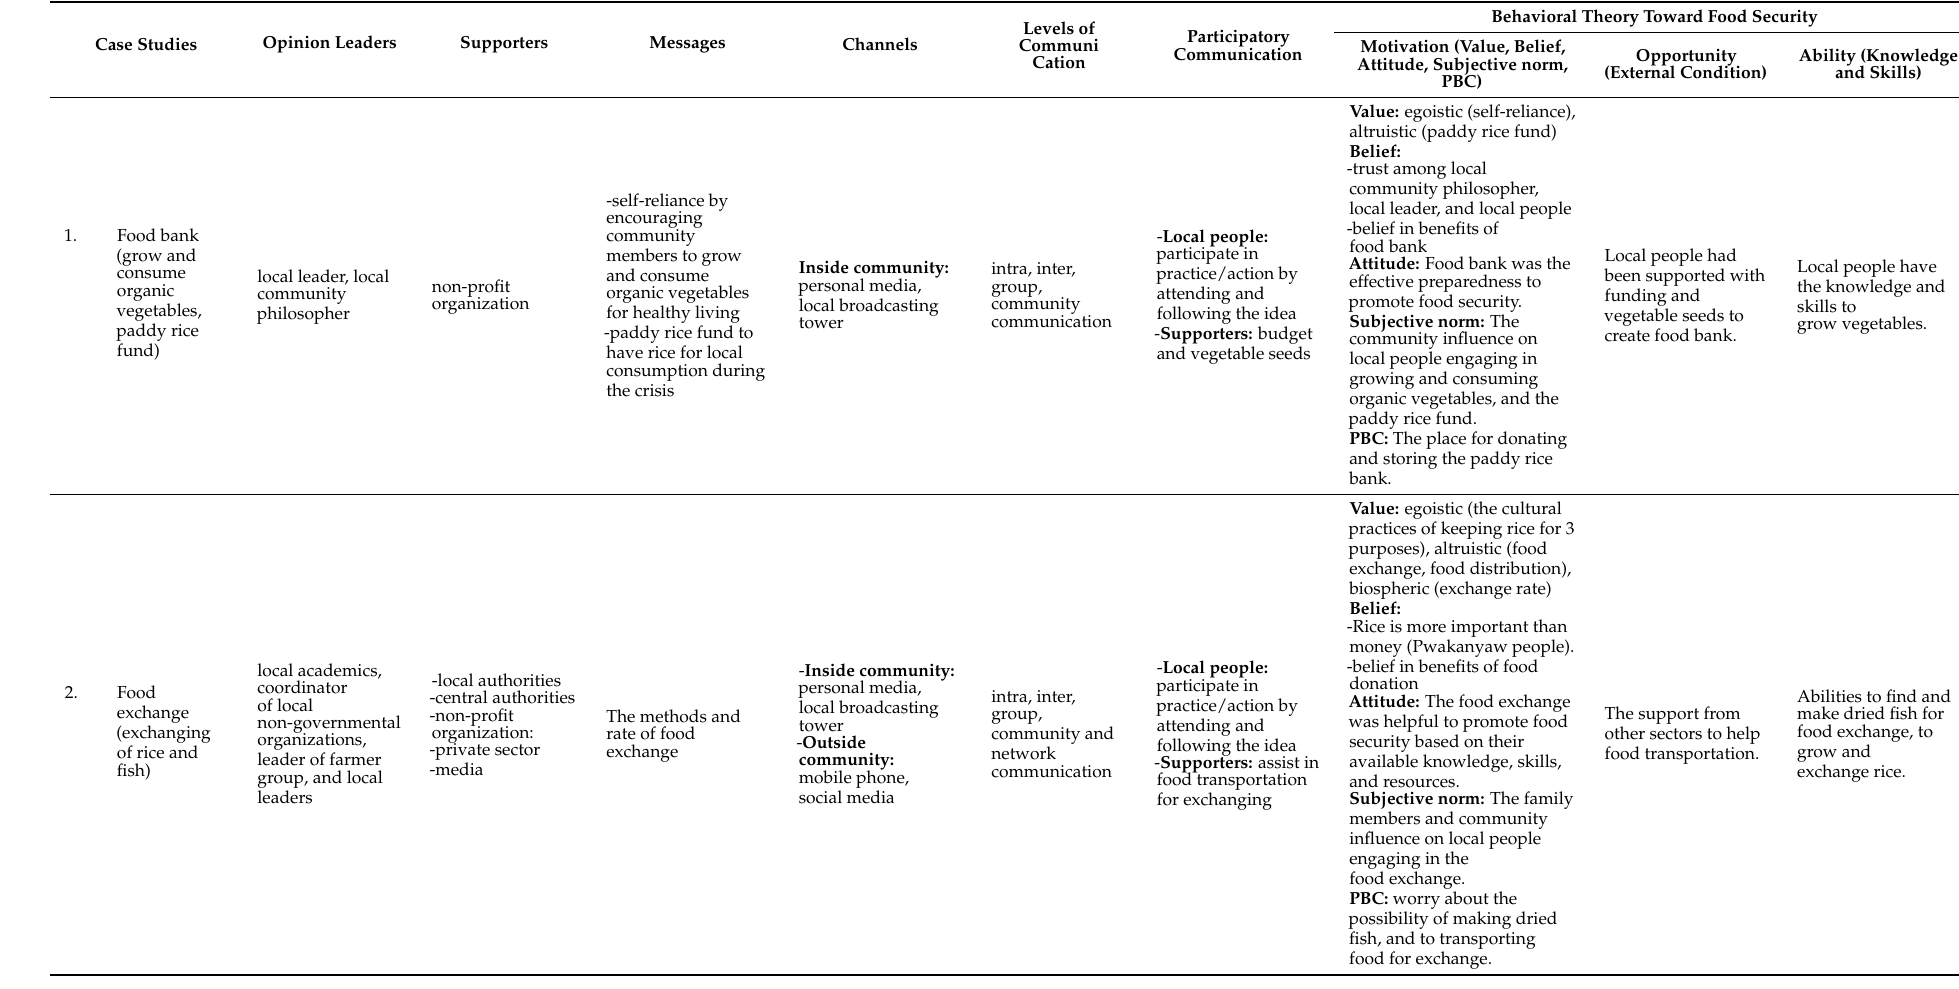
Table 2. Food security behaviors based on motivation–opportunity–ability (MOA), the theory of planned behavior (TPB), and value–belief–norm (VBN)theories and communication elements and